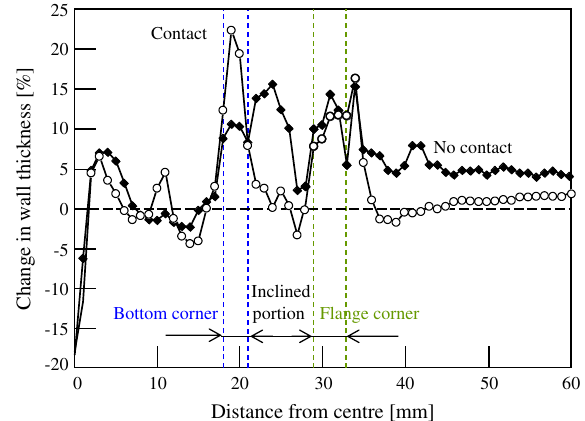
Figure 11. Distribution of change in wall thickness of cup after 3rd stage for h = 45 (cid:3) and s 2 = 22